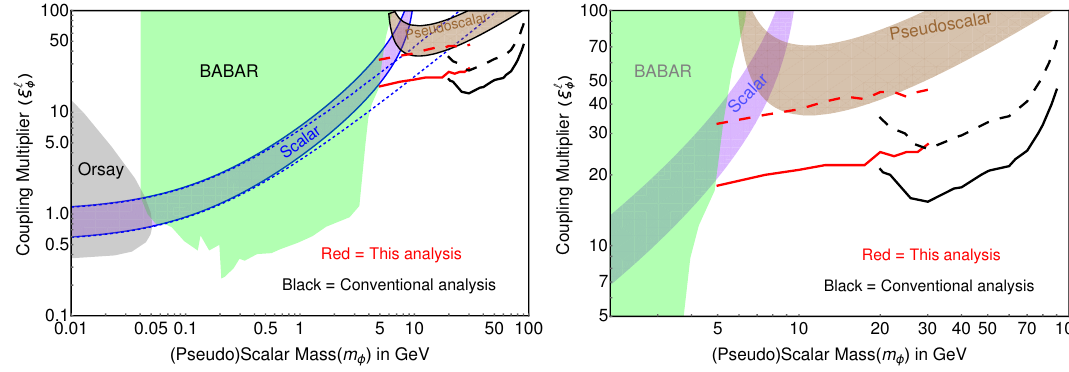
Figure 3 . Parameter space of a leptophilic spin-0 particle explaining the muon ( g − 2) anomaly. Blue (brown) colored region can explain ( g − 2) µ when the spin-0 particle is a scalar (pseudoscalar). The negative two-loop effect in scalar case is apparent for higher mass range where total contribution in inside blue solid region differs from the blue dotted lines. Substantial part of the parameter space is constrained by the beam dump [27] (shown in gray) and BABAR [25] experiment (shown in green). Limit from ILC is shown in red and black curves where solid and dashed line corresponds to exclusion( 2 σ ) and discovery( 5 σ ) limit at ILC250 with 2 ab − 1 of data. Limit of conventional analysis is taken from ref